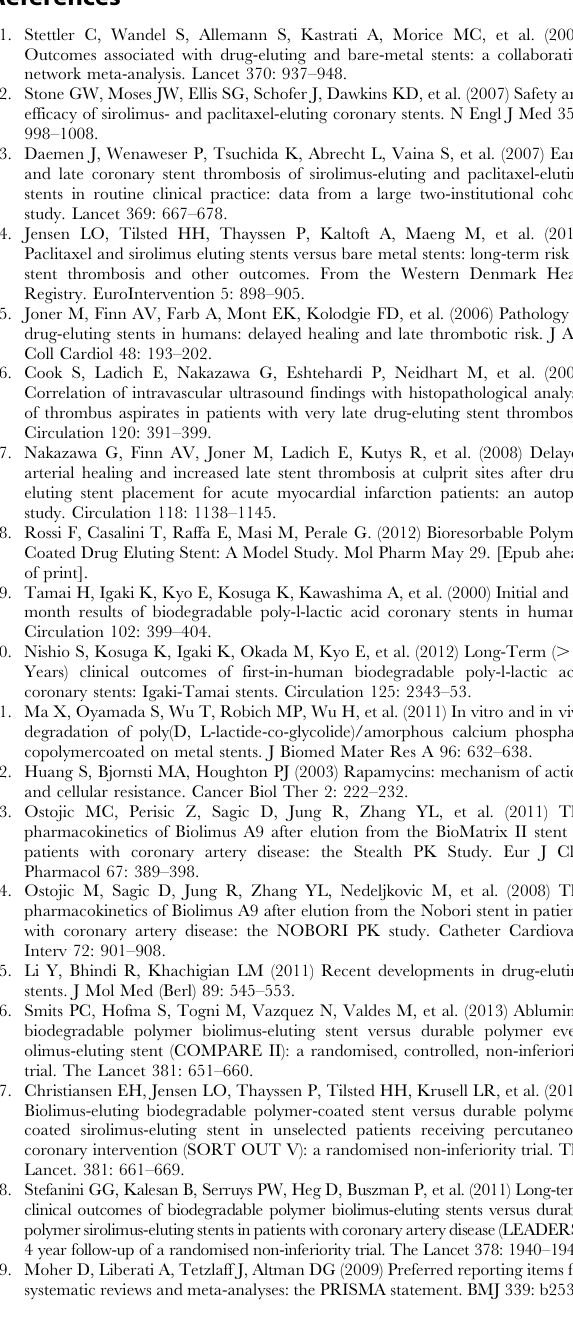
Table S1 Results of meta-regression.